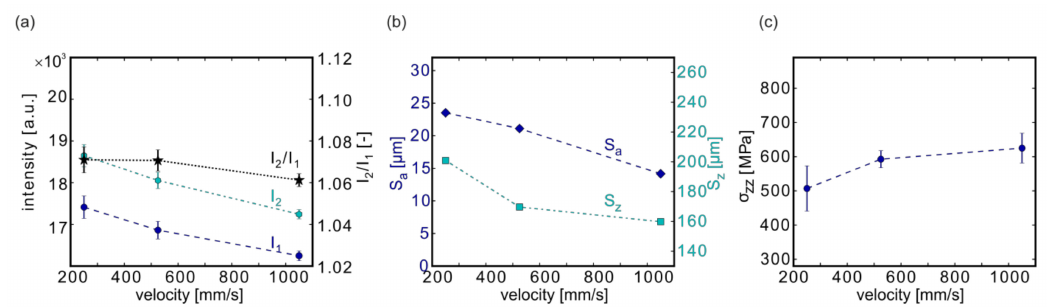
Figure 9. Influence of the scanning velocity on the MPM data ( a ), on the surface roughness ( b ), and on the residual stresses ( c ). Depicted are the results from samples #13 (250 mm / s), #05 (525 mm / s), and #14 (1050 mm / s). Note: The lines connecting the measurement points are only provided as a guide for the